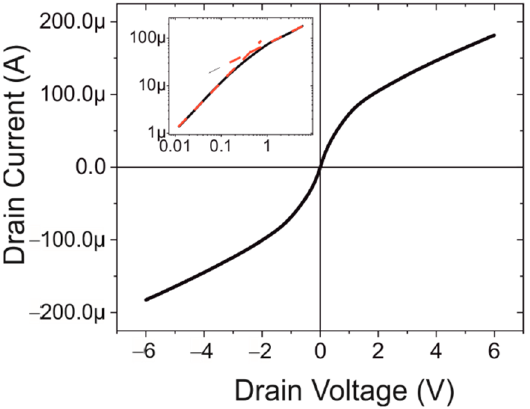
Figure 2. The IV-characteristics of the bare silicon device between the source and drain contact. The inset shows the log-log plot of the positive bias potentials. The red dotted lines indicate the slope, which is 1, indicating Ohmic behaviour at low potential and 0.5 at higher voltage.